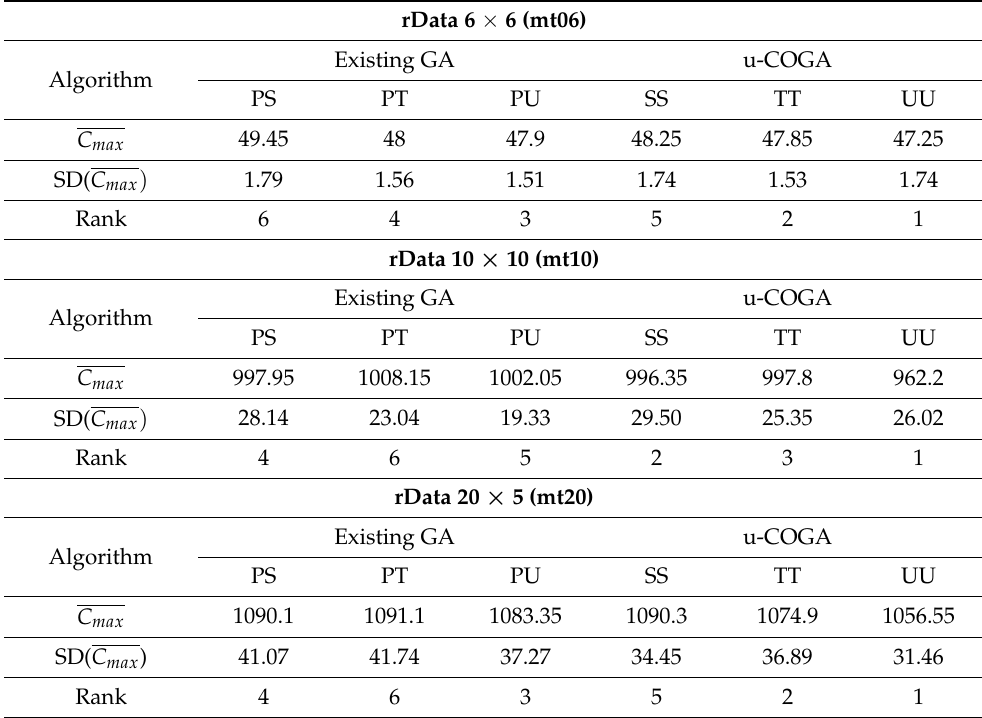
Table 7. Experiment results for